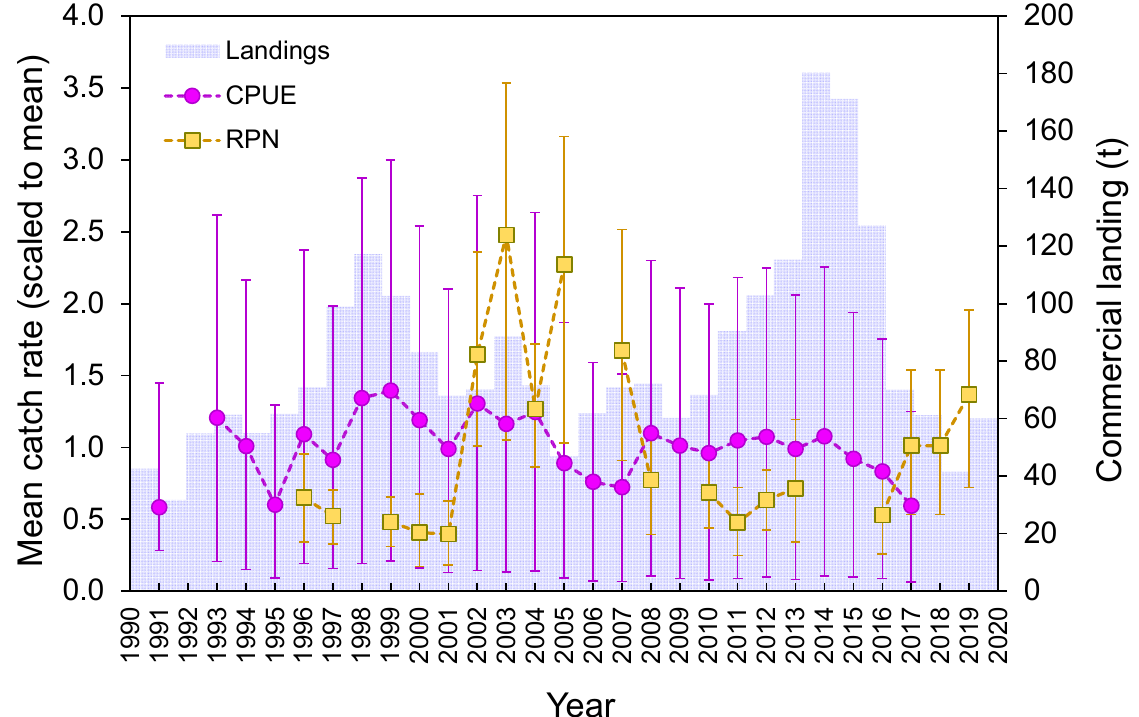
Figure 9. Official commercial landings (tons), mean ( ± 0.95 confidence interval), standardized CPUE (kg days at sea − 1 vessel − 1 ), and mean ( ± 0.95 confidence interval) survey-derived RPN (ind. 10 − 3 hooks) for the thornback ray Raja clavata in the Azores.